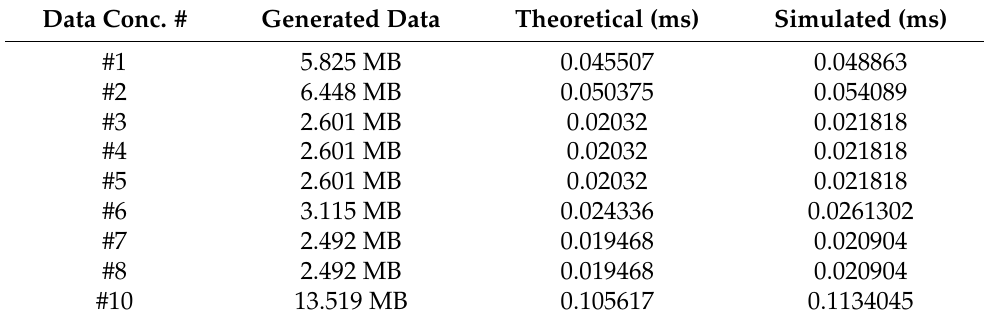
Table 13. Transmission delays per data